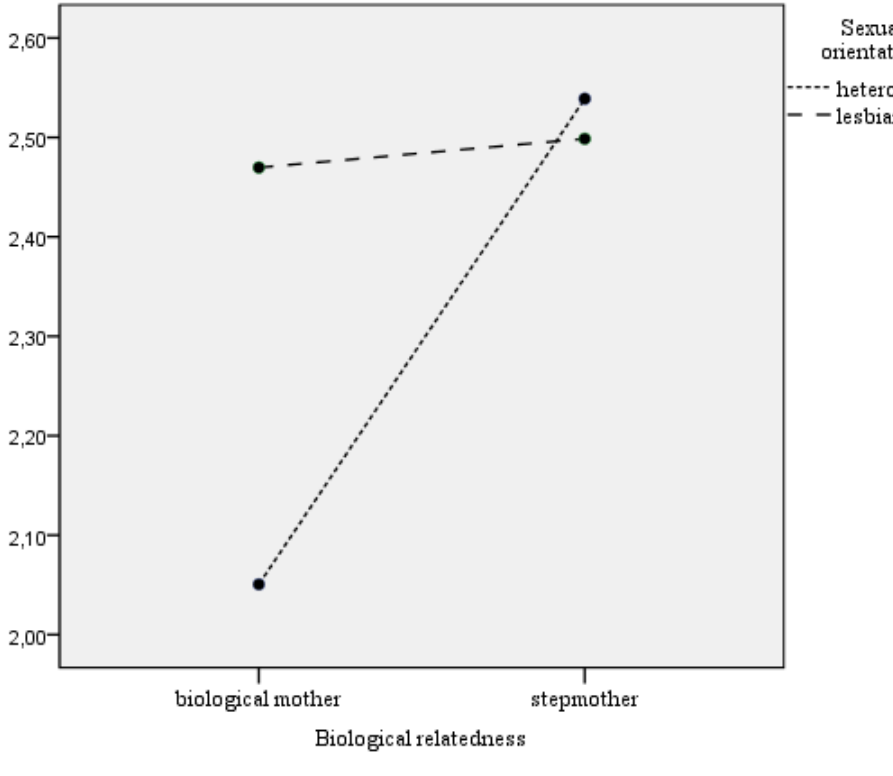
Figure 3. Ancova Interaction for Evaluations on Attributions of Responsibility.